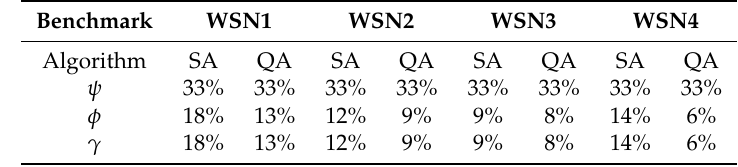
Figure 6. The average execution time. Table 5. Improvement percentage of Cuckoo-PC against other baselines.